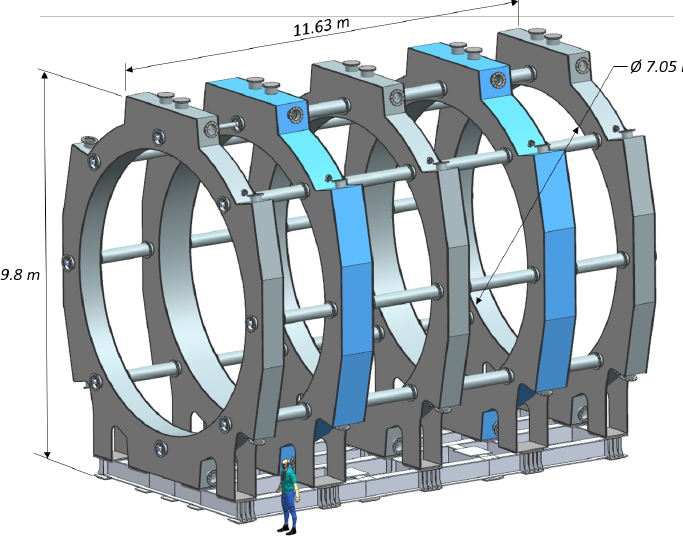
Figure 54. 5-coil Helmholtz concept for ND-GAr superconducting